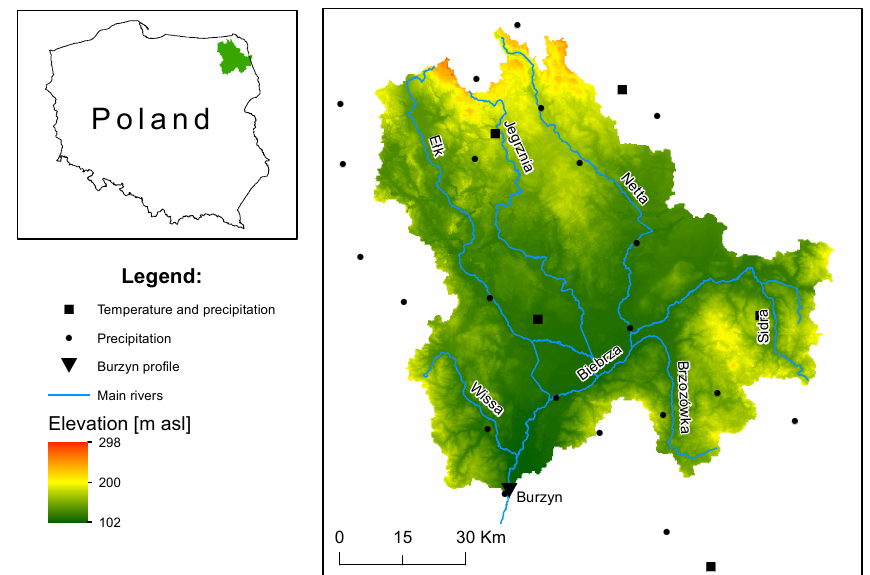
Figure 1. Topography of the study area and location of meteorological stations.